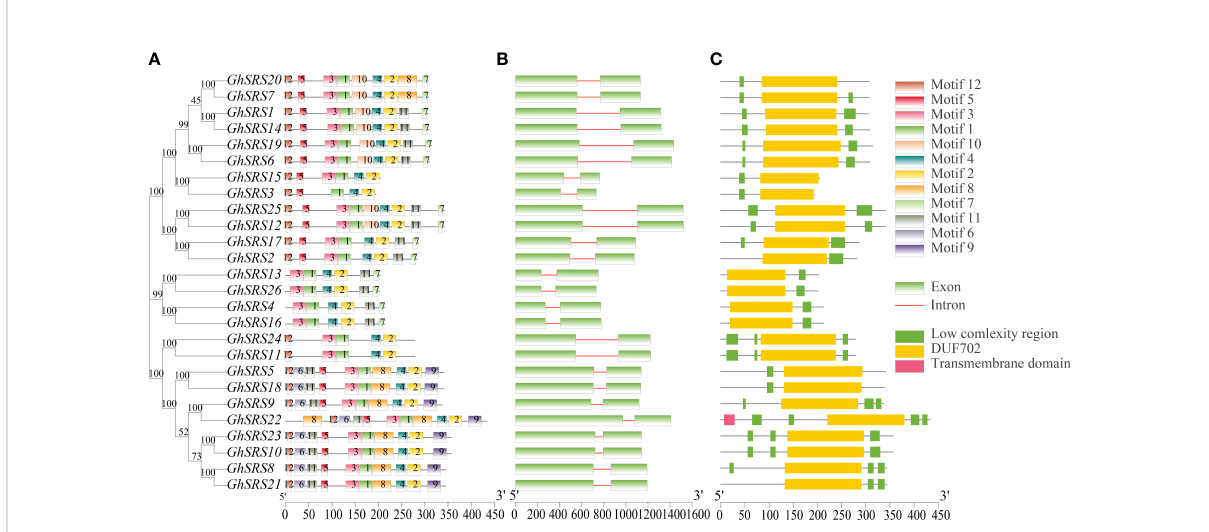
FIGURE 3 Conserved motifs, gene structures and conserved domains of SRS family members (A) Conserved motifs identi fi cation through Multiple EM for Motif Elicitation (MEME) (B) Gene structures of SRS proteins, green rectangle represents the exon of SRS genes and line represents intron (C) Conserved motifs of SRS proteins, the blue rectangle represents the SRS conserved domain containing the RING-like zinc- fi nger domain (CX